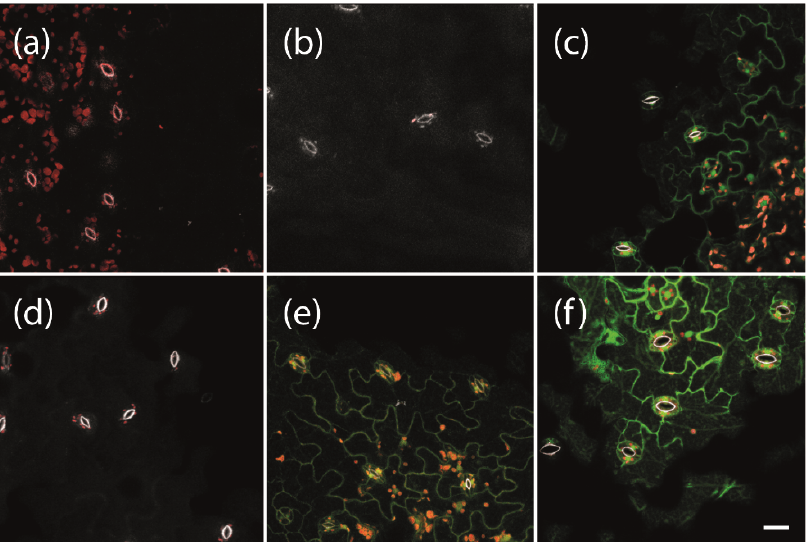
Figure 1. Induction of GFP expression depending on β -estradiol concentrations. Two-week-old